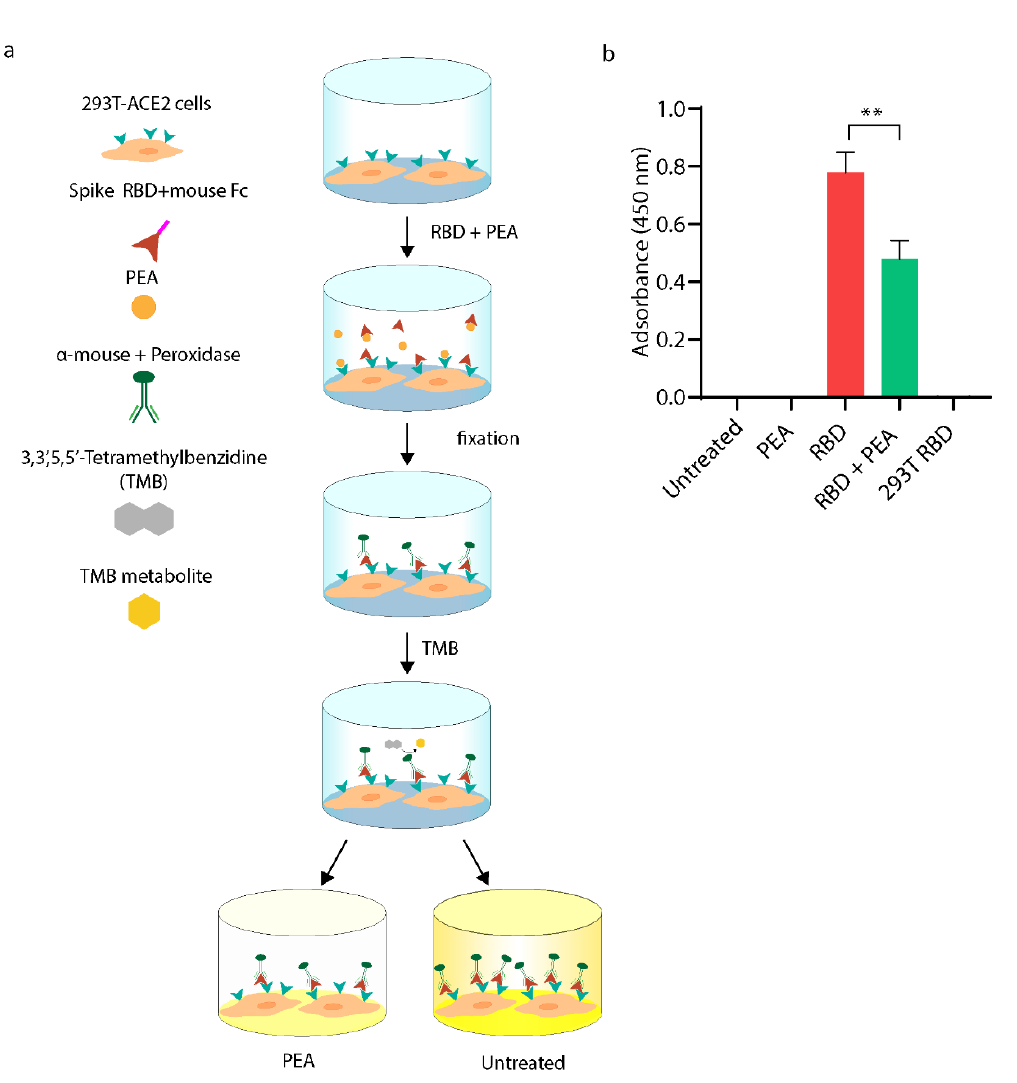
Figure 3. Cell-based ELISA assay performed on 293T-ACE2 cells. ( a ) Schematic illustration of experimental workflow. Briefly, 293T-ACE2 cells were exposed to equimolar concentrations of PEA (10 µ M) and recombinant SARS-CoV-2 RBD fused with murine Fc. Then, cells were fixed and stained with peroxidase-labeled α -mouse IgG. ( b ) Statistical analysis of cell-based ELISA assay shown in a. Data are expressed as means ± SD and were analyzed by a one-way ANOVA (N = 4, α = 0.05, ** p < 0.001).